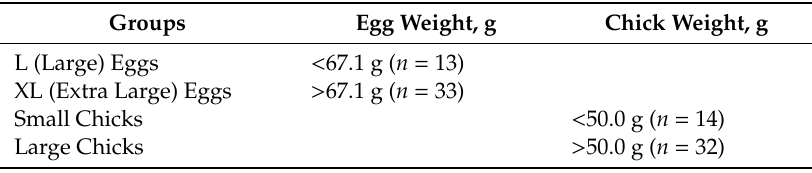
Table 1. Criteria for making various groups of egg and chick